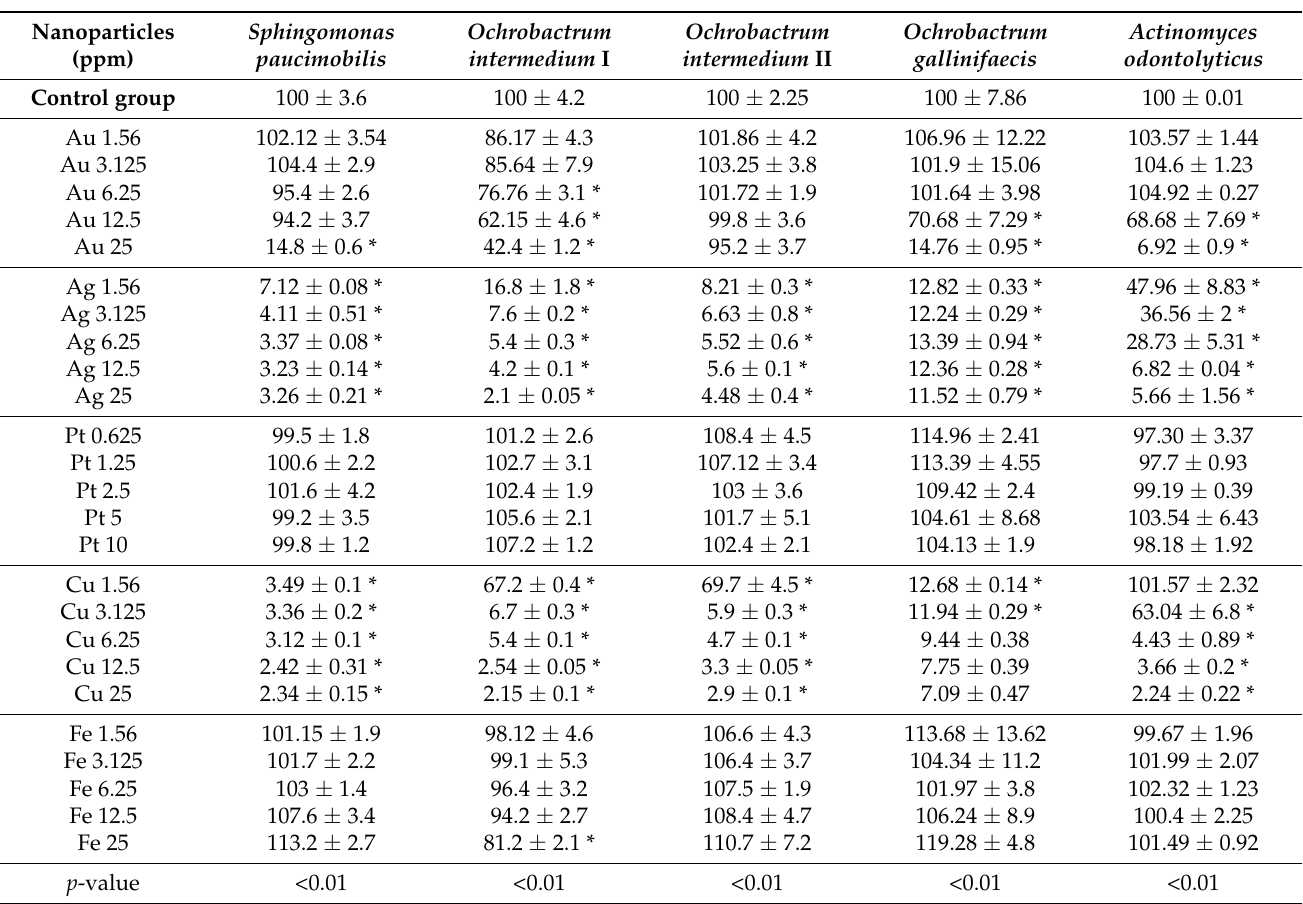
Table 5. Viability analysis of the microorganisms isolated from ulcerated hoof sores and exposed to Au, Ag, Pt, Cu, and Fe